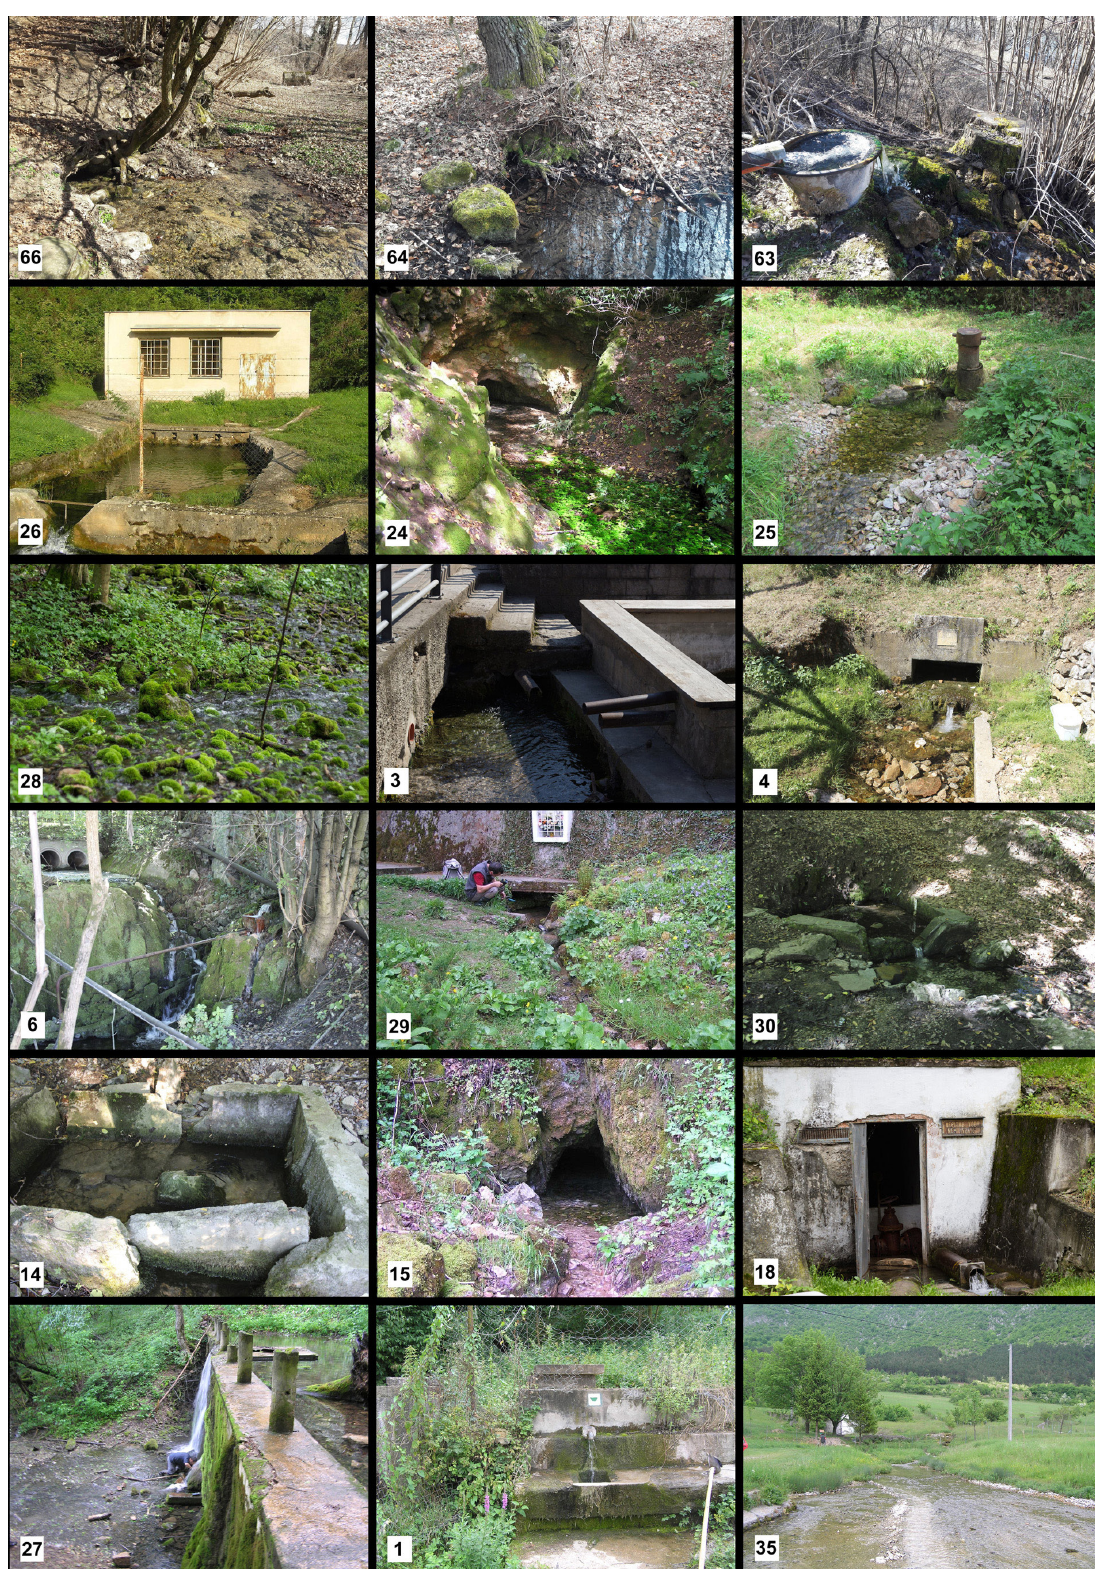
Fig. 4. Selected localities of H. kissdalmae Erőss & Petró, 2008. Image numbers correspond to locality numbers in Table